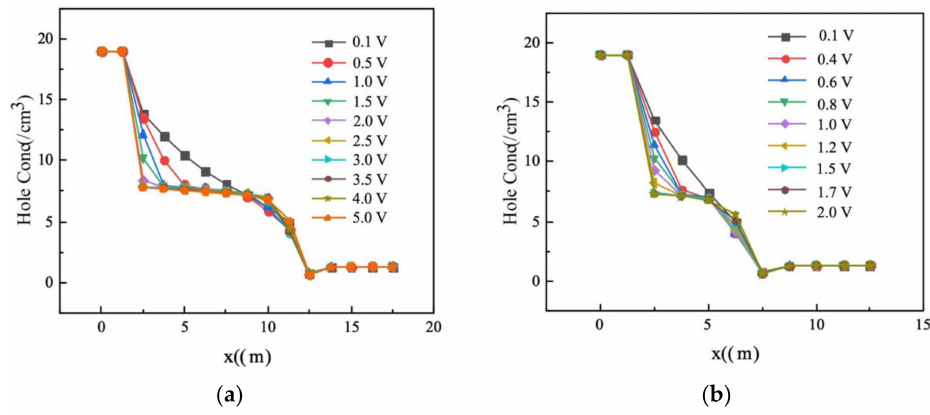
Figure 9. Hole concentration curves (log scale) along x -axis for detectors with electrode spacings of ( a ) 10 µ m and ( b ) 5 µ m.